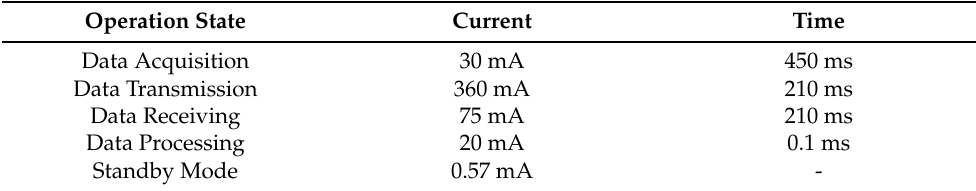
Table 3. The current measurements in the sensor node for each operation